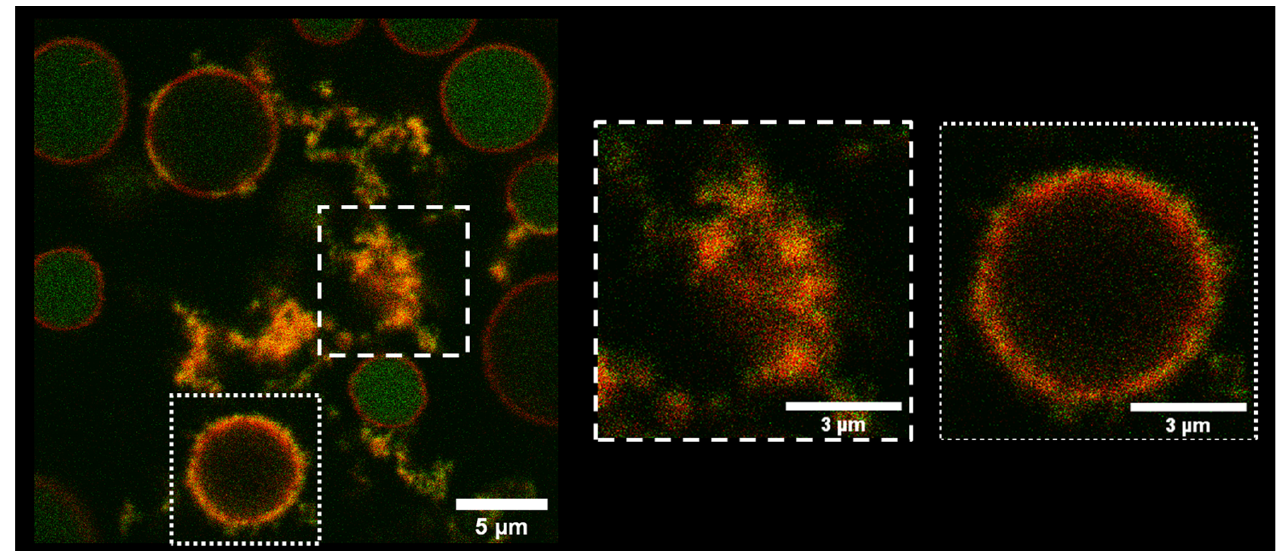
Figure 2. The 1024 × 1024 pixels representative fluorescence image shows GPMVs labeled with NR (red channel) after the addition of 10 μ M CF-TP10 (green channel). The overlap of the two channels at the edges of the vesicles and in the aggregates in solution reveals protein–vesicles co-localization. This causes a clear modification in the membrane morphology (magnification highlighted with a dotted box) that can lead to the rupture of the membranes (magnification highlighted with a dotted box).